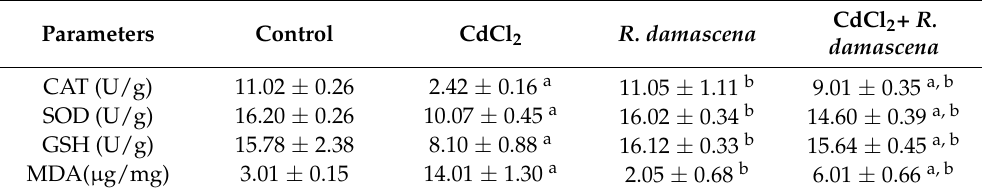
Table 5. Effects of R. damascena methanolic extract (100 mg Kg − 1 ) on oxidative stress enzymes and